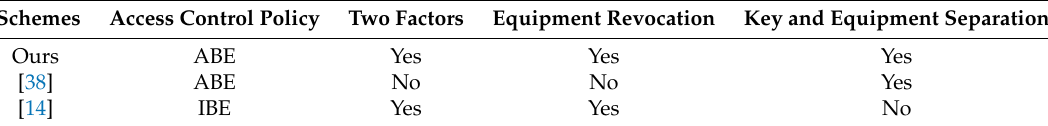
Table 2. Features comparison of related schemes.